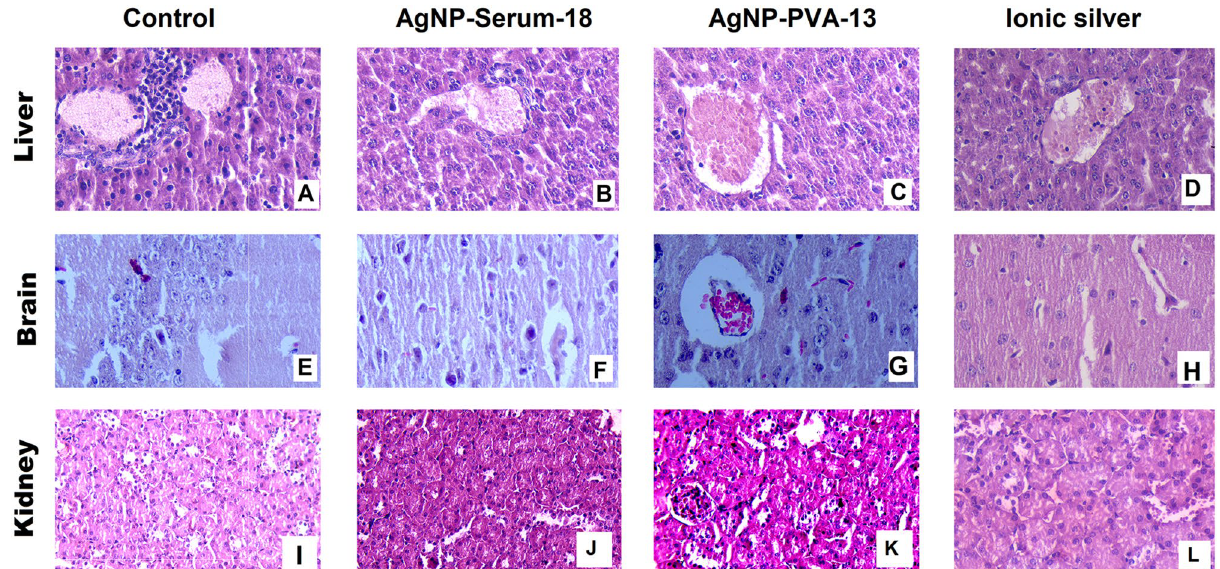
Figure 6. Hematoxylin and eosin (H&E)-stained liver, brain and kidney section from mice in different groups. ( A ) Liver section of mice in the control group showing normal histology and hepatocytes arranged in the hepatic cords. ( B ) Liver sections of mice in the group that received 3570 µg/kg AgNP-Serum-18 (I.V), showing: normal histology. ( C ) Liver of mice in the group that received 357 µg/kg AgNP-PVA-13 showing hepatocellular vacuolation and focal area of haemorrhage in the hepatic parenchyma. ( D ) Liver sections of mice in the group that received 3570 µg/kg ionic silver as a control (IV), showing: normal histology. ( E ) Brain section of mice in the control group showing normal histology. ( F ) Brain sections of mice in the group that received 3570 µg/ kg AgNP-Serum-18 (I.V), showing: normal histology. ( G ) Brain of mice in the group that received 357 µg/ kg AgNP-PVA-13 showing signs of early neuronal injury, focal inflammatory cellular infiltration and vascular congestion. ( H ) Brain sections of mice in the group that received 3570 µg/kg ionic silver as a control (I.V), showing: normal histology. ( I ) Kidney section of mice in the control group showing normal glomerulus. ( J ) Kidney section of mice in the AgNP-Serum-18 group showing no necrosis. ( K ) Kidney section of mice in the